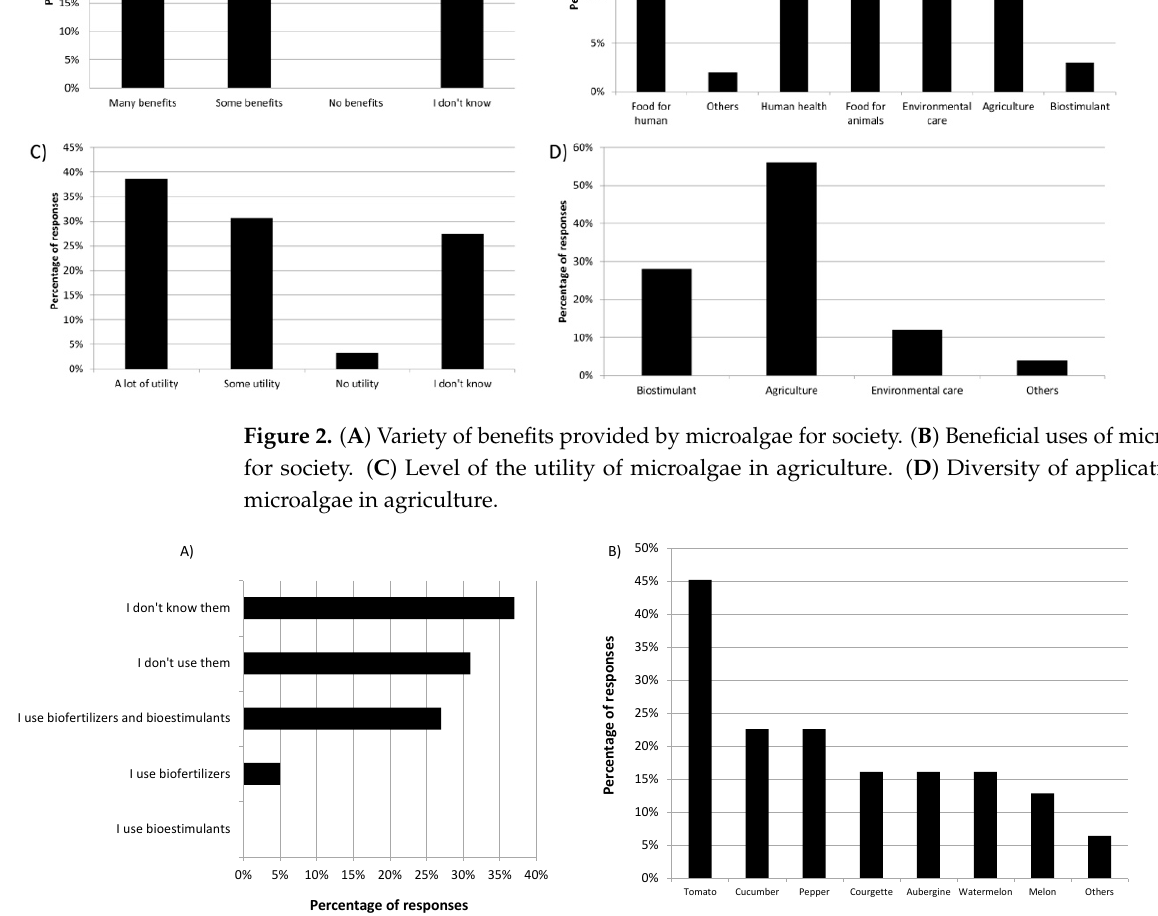
for society. ( C ) Level of the utility of microalgae in agriculture. ( D ) Diversity of applications of mi- croalgae in agriculture.